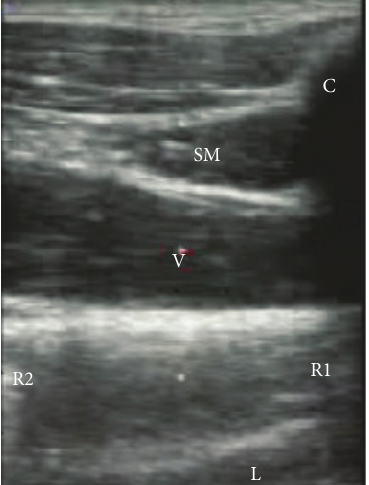
Figure 3: Ultrasound view of the subclavius muscle. SM: subclavius muscle, C: clavicle, V: subclavian vein and/or infraclavicular axillary vein, R1: first rib, R2: second rib, and L: